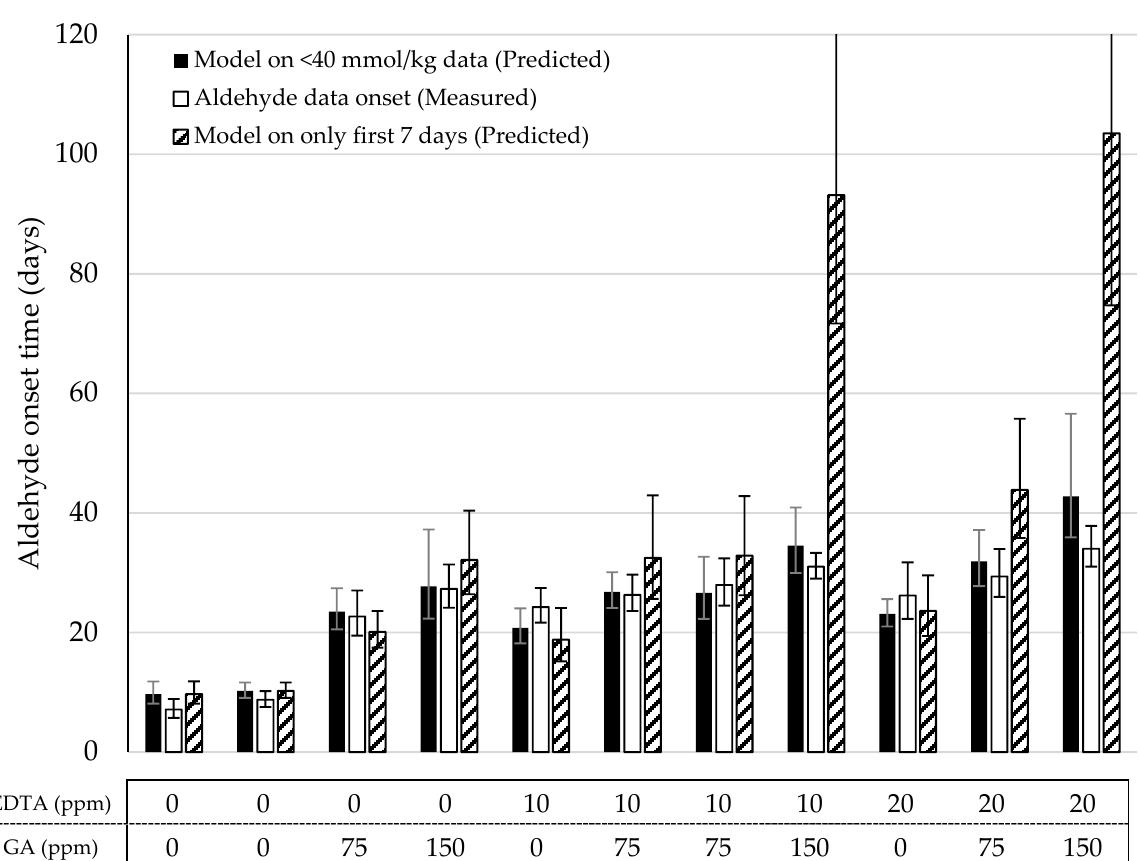
Figure 4. Overview of the predicted and measured aldehyde onset times of the mayonnaises from the model validation under Accelerated Shelf-Life Test (ASLT) conditions (50 ◦ C). The predicted aldehyde onset based on the reduced Foubert (F3) function and the prediction model (Figure 2B) was determined using all data <40 mmol/kg (closed bars) and only the first seven days (dashed bars). Open bars are the onset values based on the cross-point determination obtained from the measured sum of aldehydes. All data was measured with 1 H NMR.